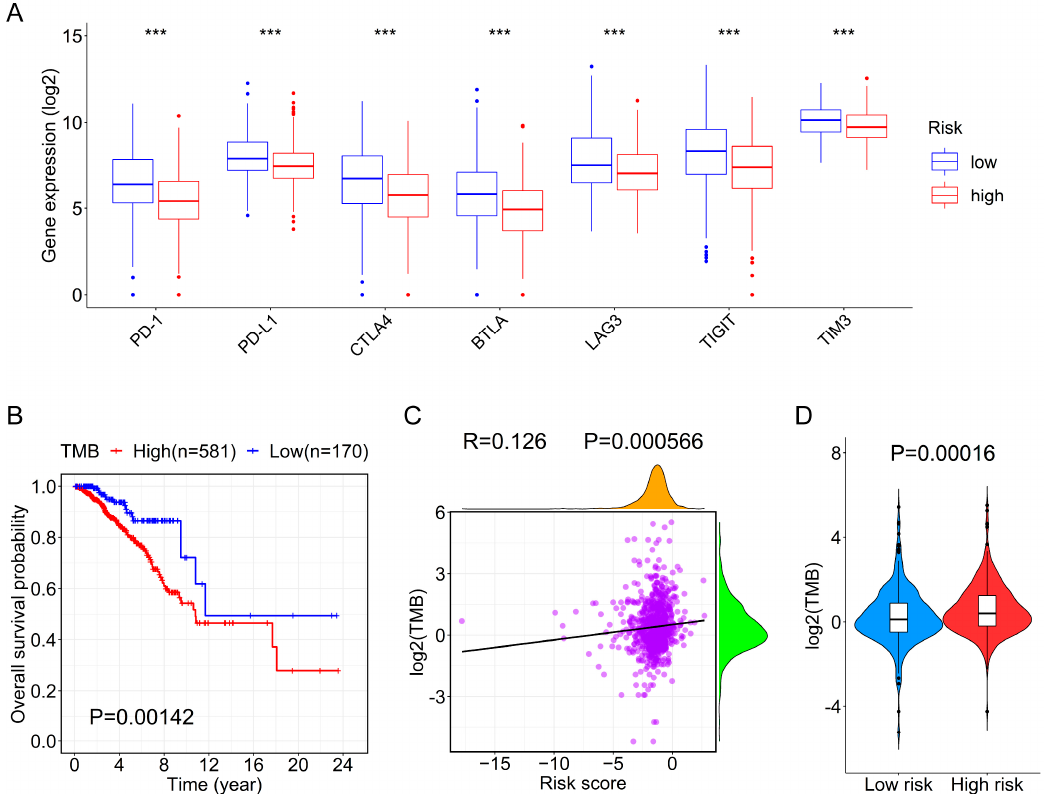
Figure 6. The correlation between the risk score and immune checkpoint genes or TMB. ( A ) The box plot shows the expression levels of some representative immune checkpoint genes between the high- and low-risk groups in the entire cohort. ( B ) The OS curve for BC patients in the high- and low-TMB groups based on the mutation data. ( C ) The correlation analysis between TMB and risk score. ( D ) The violin plot shows the difference in TMB between the high- and low-risk groups. *** P.adjust < 0.001.